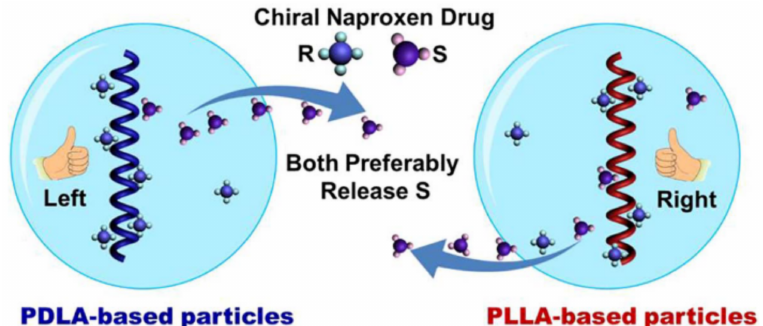
Figure 6. Polylactide-based chiral particles with an enantio-differentiating release ability. Reprinted with permission from Ref. [180]. Copyright 2018,